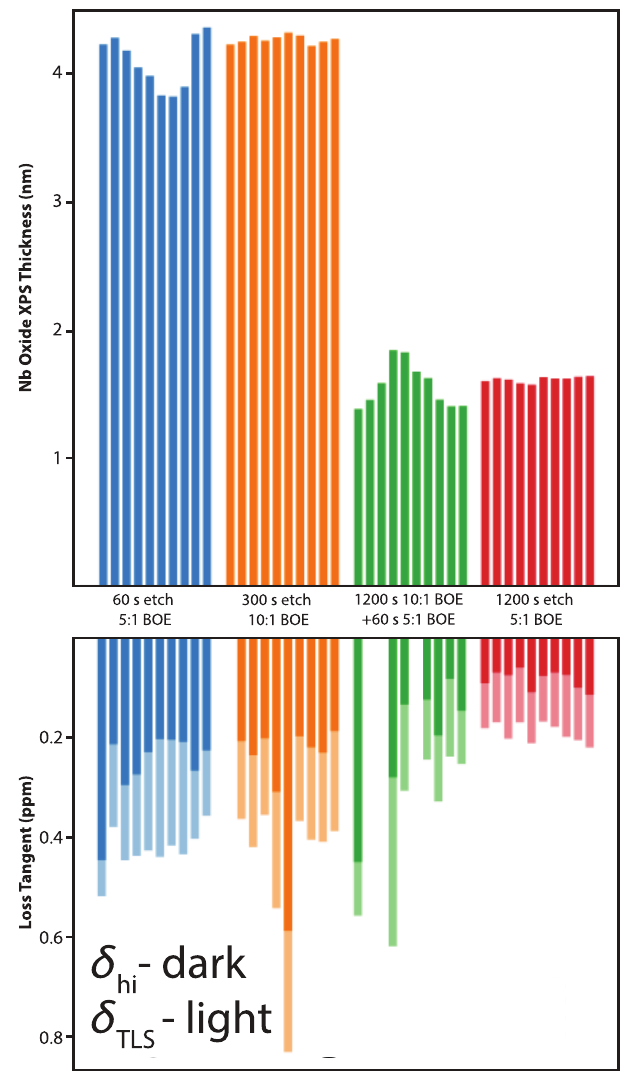
FIG. 11. A comparison of chips etched in 10:1 BOE (blue, red) with chips etched in 5:1 BOE of similar NbO x thickness. One sample is etched in 10:1 BOE only (green) and the other in both 10:1 and 5:1 BOE